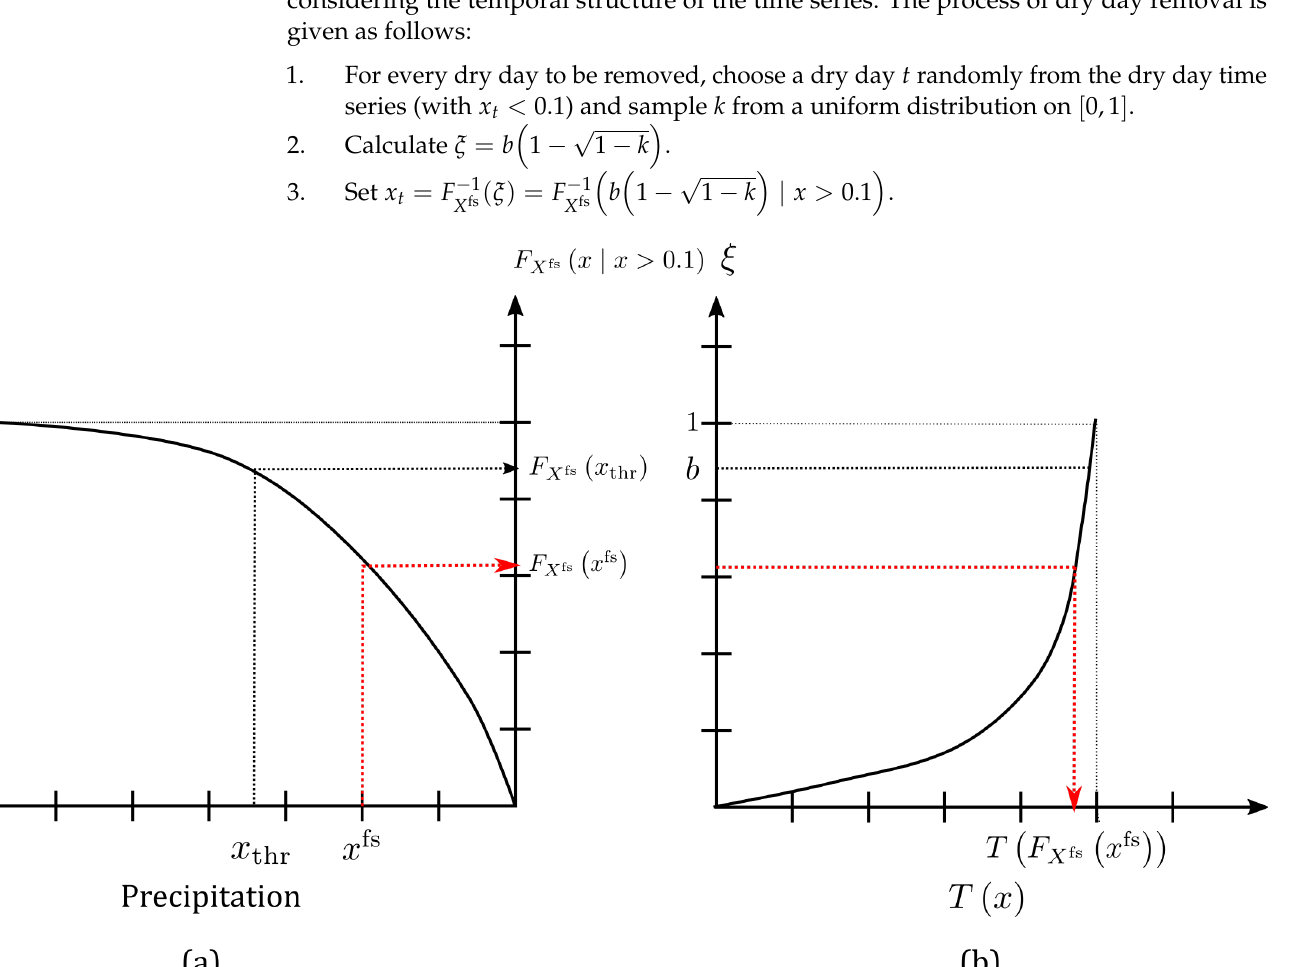
simulations, which results in Algorithm